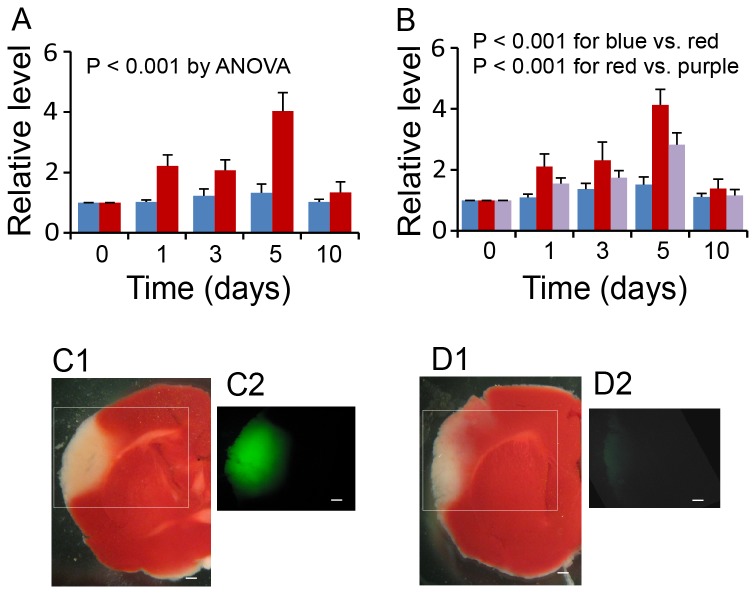
Relative serum levels of TFF3 in mice with sham operation and cerebral ischemia/reperfusion injury, and contribution of the liver to serum TFF3.(A) Relative serum level of TFF3 by ELISA. Blue: Sham controls. Red: Cerebral ischemia/reperfusion injury. P<0.001 between sham controls and cerebral ischemia/reperfusion injury at day 1, 3, 5, and 10 days by ANOVA (n = 8). (B) Contribution of the liver to serum elevation of TFF3 in cerebral ischemia/reperfusion injury. Blue: Controls with cerebral and hepatic sham operation. Red: Cerebral ischemia/reperfusion injury with hepatic sham operation. Purple: Cerebral ischemia/reperfusion injury with partial hepatectomy. P<0.001 between cerebral/hepatic sham operation and cerebral injury with hepatic sham operation, and P<0.001 between cerebral injury with hepatic sham operation and cerebral injury with partial hepatectomy at day 1, 3, 5, and 10 days by ANOVA (n = 8). For both panel A and B, data at time zero were from healthy mice. The relative level was calculated in reference to the data at time zero. (C) Presence of fluorescein-TFF3 in the ischemic cerebral lesion, but not in the intact brain, at 1 hr following intravenous administration of fluorescein-TFF3 to a mouse with 24-hr cerebral ischemia/reperfusion injury. C1: A TTC-stained section of the injured cerebral hemisphere showing a cerebral infarct (white) and intact cerebrum (red). C2: a fluorescence micrograph from the selected area of panel C1, showing fluorescein-TFF3 (green) in the cerebral infarct, but not in the intact cerebrum. Scale: 1 mm. (D) Absence of fluorescence in the ischemic cerebral lesion at 1 hr following intravenous administration of non-conjugated TFF3 to a mouse with 24-hr cerebral ischemia/reperfusion injury. D1: A TTC-stained section of the injured cerebral hemisphere showing a cerebral infarct (white) and intact cerebrum (red). D2: a fluorescence micrograph from the selected area of panel D1, showing the lack of green fluorescence in the ischemic cerebral lesion. Scale: 1 mm.